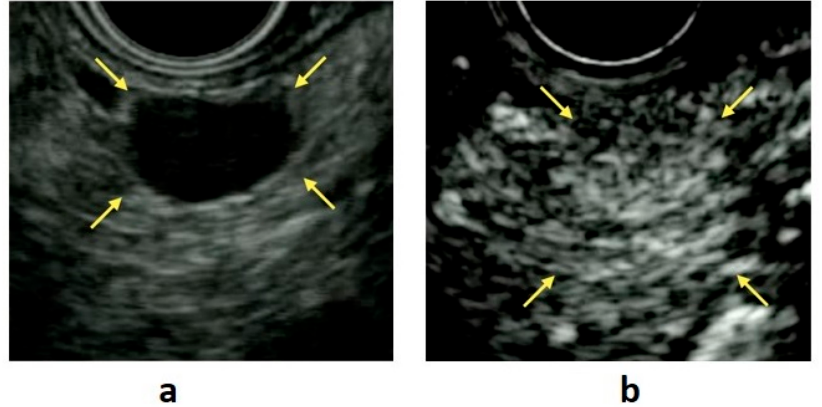
Figure 1. ( a ) B-mode endoscopic ultrasound (EUS): a circular hypoechoic mass is seen in the body of the pancreas (yellow arrow). ( b ) Contrast-enhanced EUS: the mass shows early enhancement compared with the surrounding pancreatic parenchyma (yellow arrow).